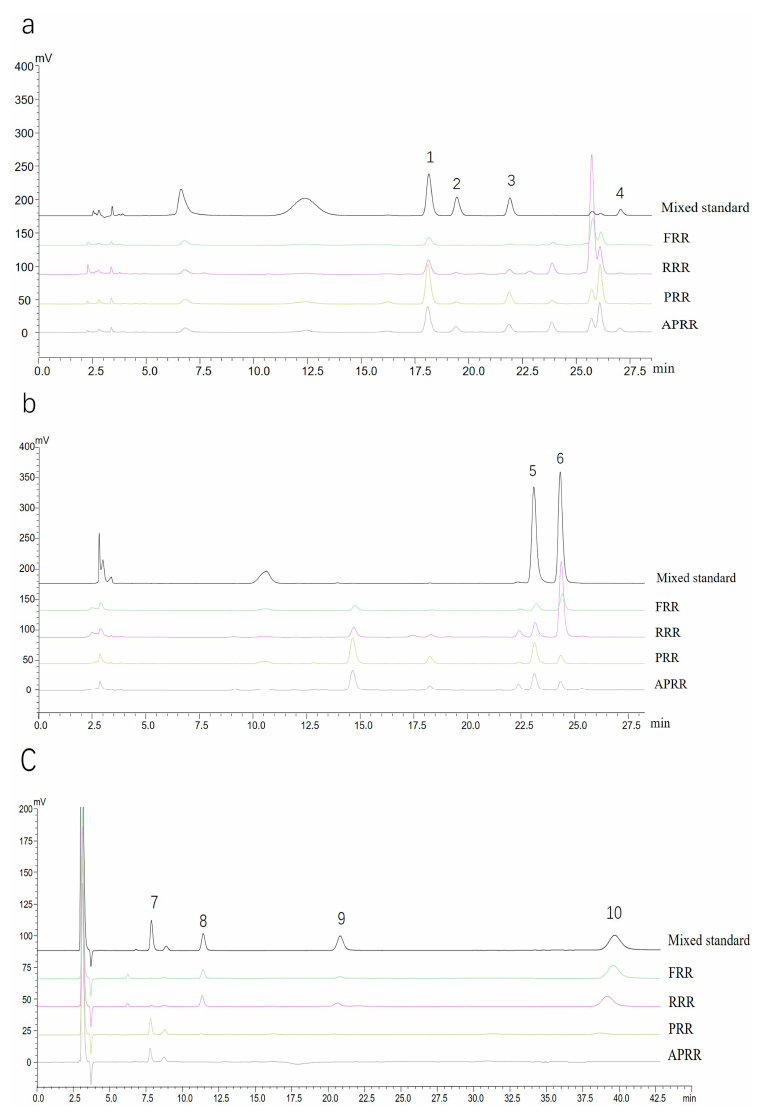
Figure 1. Representative chromatograms of saccharides in four kinds of Radix Rehmanniae (RR). ( a , b ): High-performance liquid chromatography with diode array detector DAD (HPLC-DAD) chromatograms (1. manninotriose, 2 mannose, 3 melibiose, 4 arabinose, 5 glucose, 6 galactose); ( c ) HPLC with refractive index detector (HPLC-RID) chromatograms (7. fructose, 8. sucrose, 9. raffinose, 10. stachyose). APRR: another processed RR; FRR: fresh RR; PRR: processed RR; RRR: raw RR.